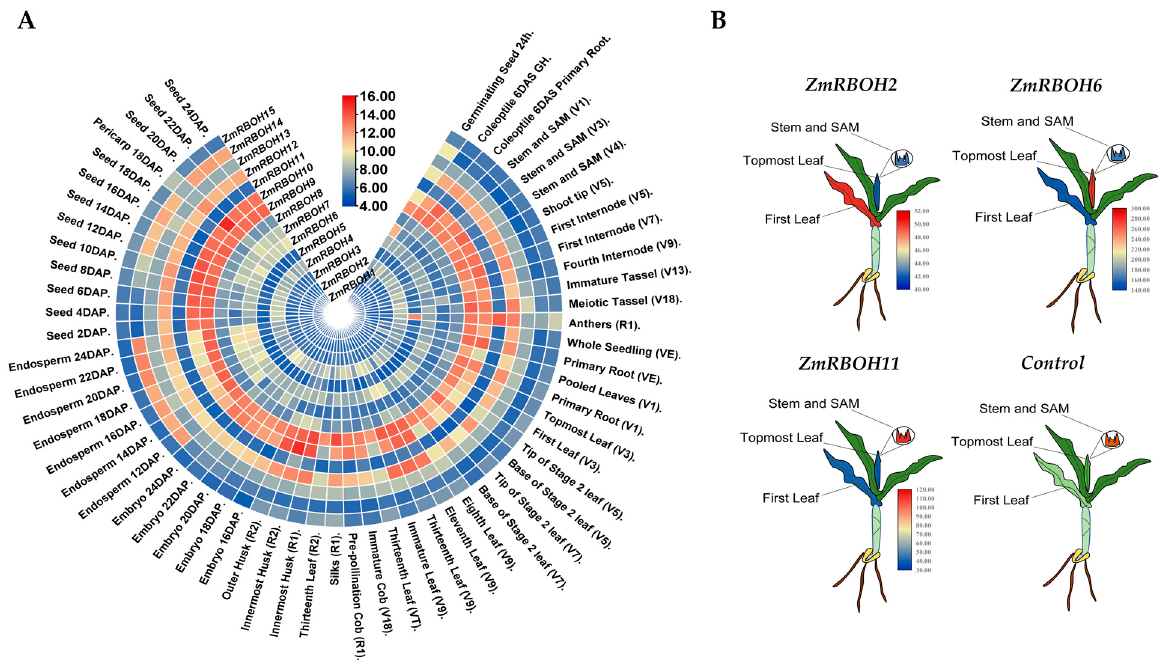
Figure 6. Differential expression of ZmRBOH genes in different tissues and developmental stages of maize. ( A ) The integrative heatmap shows the different expressed ZmRBOH genes in different tissues and developmental stages of maize. ( B ) Heatmaps of phenotype simulation of different expressed representative ZmRBOH genes in V2 stage of maize. Colors represent log2-fold change comparing relative expression, color scale is provided. Red: high expression level; blue: low expression level.